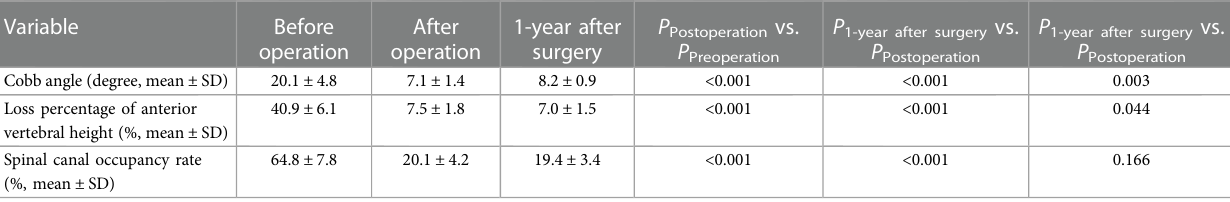
TABLE 3 Comparison of Cobb angle, loss percentage of anterior vertebral height, and spinal canal occupancy rate of 15 patients before operation, after the operation, and at 1-year after surgery.